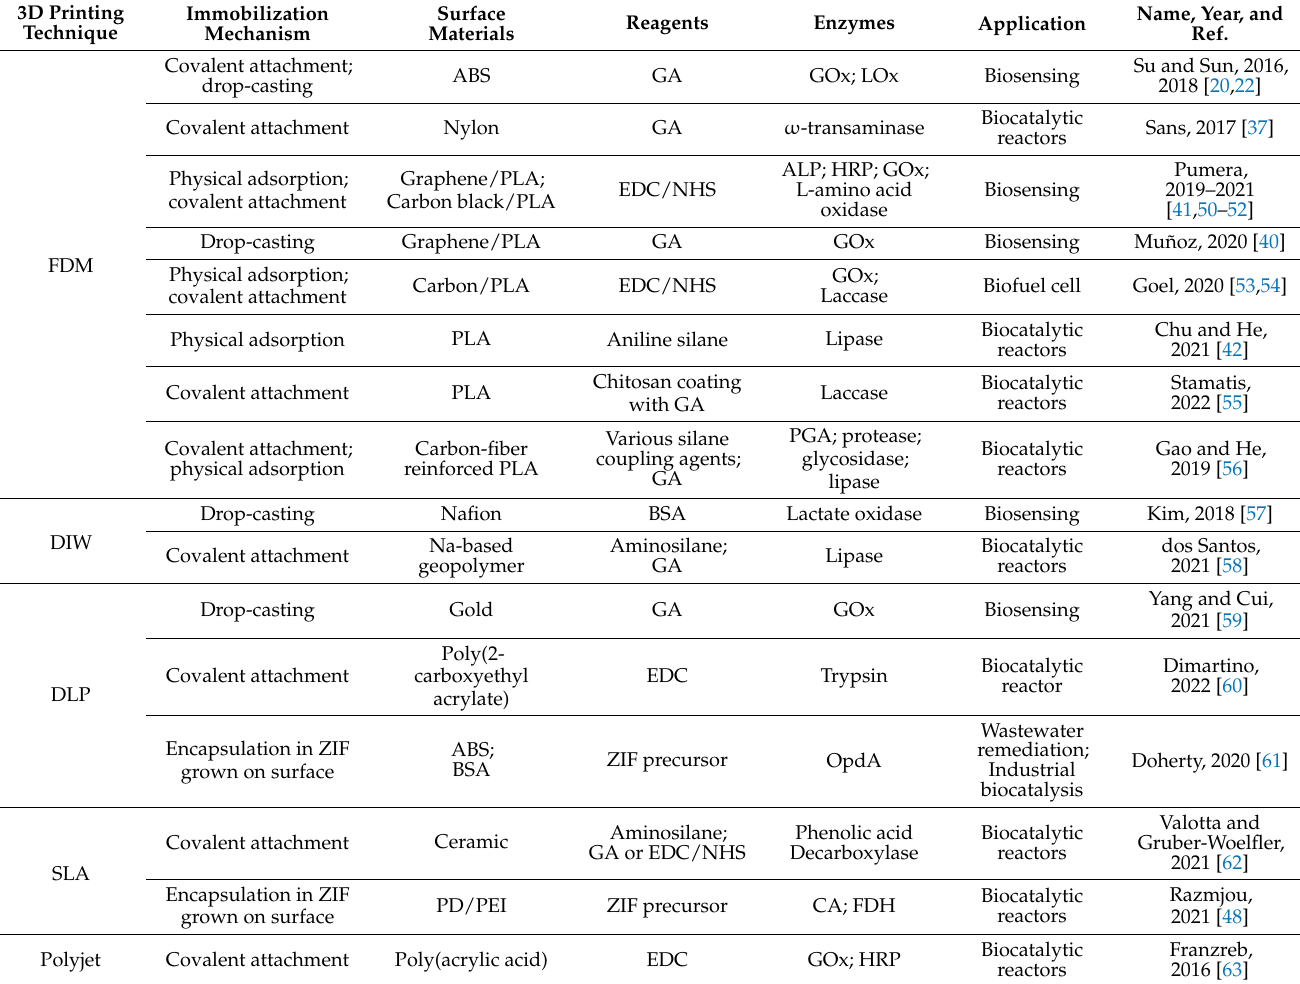
Table 2. Techniques for post-printing enzyme